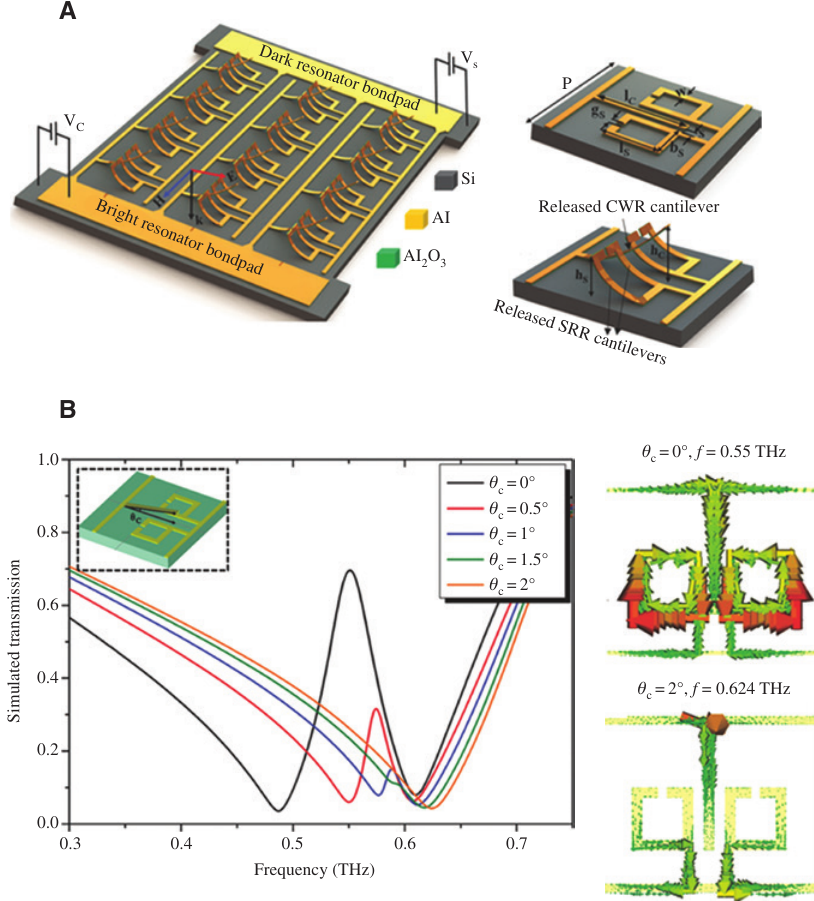
Figure 4: (A) Schematic of the EIT device based on the proposed MEMS metamaterial with independently reconfigurable microcantilevers, CWR, and metamaterial SRR, respectively. (B) Simulated transmission spectra of MEMS metamaterial, varying the angle θ = 0 degree disappears for θ = 2 ° . The corresponding simulated surface currents in the two scenarios transmission window at 0.55 GHz for θ c c are also reported. Reprinted and adapted with permission from Pitchappa et al.